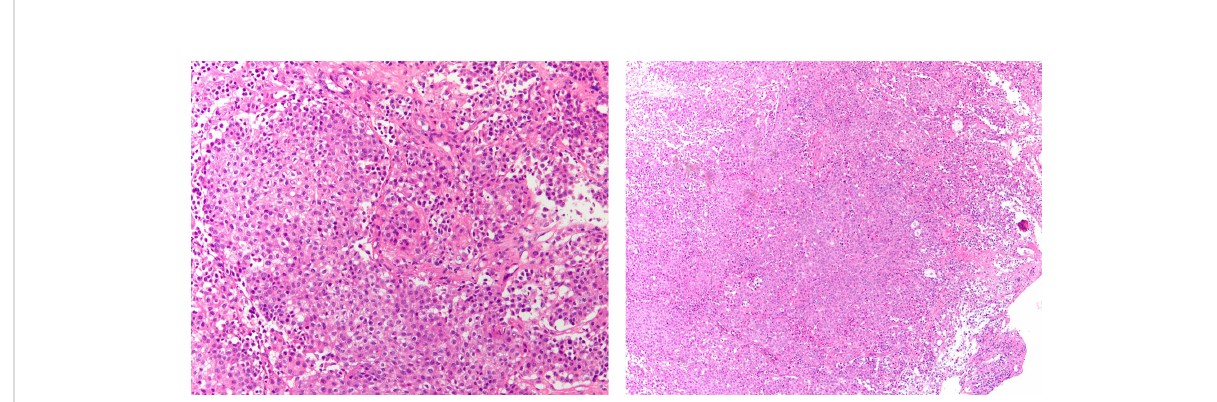
FIGURE 3 Histopathological fi ndings of pericardial effusion by paraf fi n embedding of cell sediment. IHC yielded the following: PCK (+), Claudin-4(+), TTF-1 (+), NapsinA(+), Calretinin ( – ), CK5/6 ( – ), P40 ( – ), EGFR ( – ), C-met ( – ), Ros-1 ( – ),